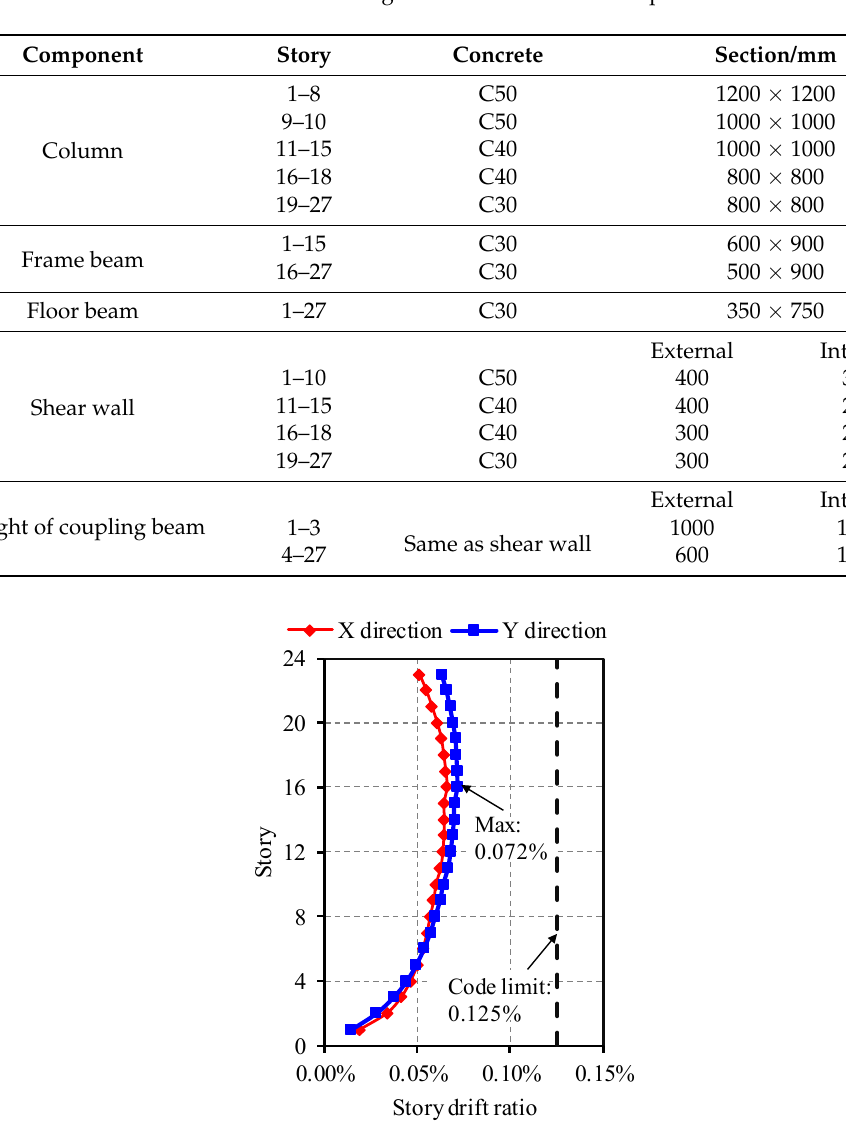
Table 4. Concrete strength and section size of components.